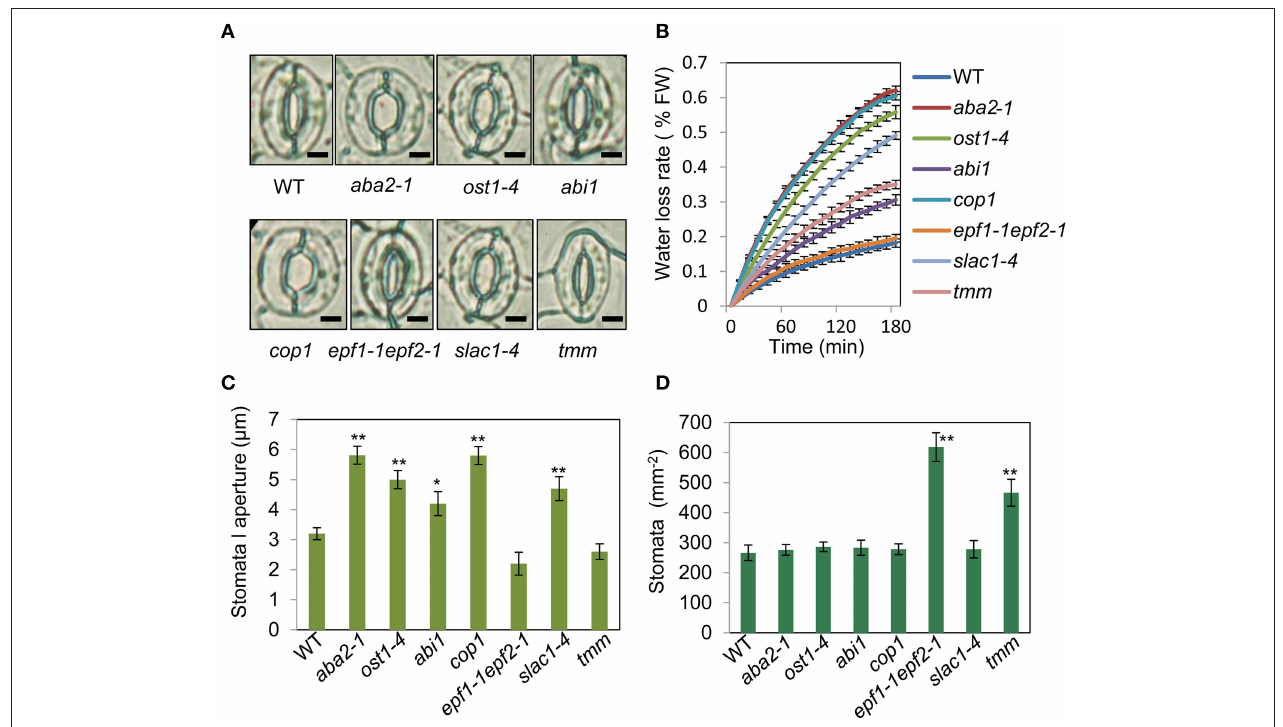
FIGURE 5 | Analysis of several stomatal mutants in terms of stomatal aperture size and stomatal density. (A) Representative images of stomata of wild-type and stomatal mutant plants at noon under unstressed conditions in soil. The epidermis of fifth leaf were quickly separated and observed by microscopy. Bar = 10 µ m. (B) The aba2-1 , cop1 , ost1-4 , slac1-4, abi1 , and tmm mutants lost water more rapidly than the wild-type plants. Water loss from the detached leaves of plants in fresh weight (FW) at day 35. Leaves 5 and 6 were selected for experiments. The rate of water loss from high to low was as follows: aba2 > cop1 > ost1-4 > slac1-4 > tmm > abi1 > epf1-1epf2-1 > WT. (C,D) Abaxial stomatal densities and stomatal aperture sizes of wild-type plants and stomatal mutants with fifth fully expanded leaves. Bars indicate standard errors, while asterisks indicate significant differences from wild-type and mutant plants under Student’s test ( * p < 0.05 , ** p < 0.01 ); three experiments were performed with similar